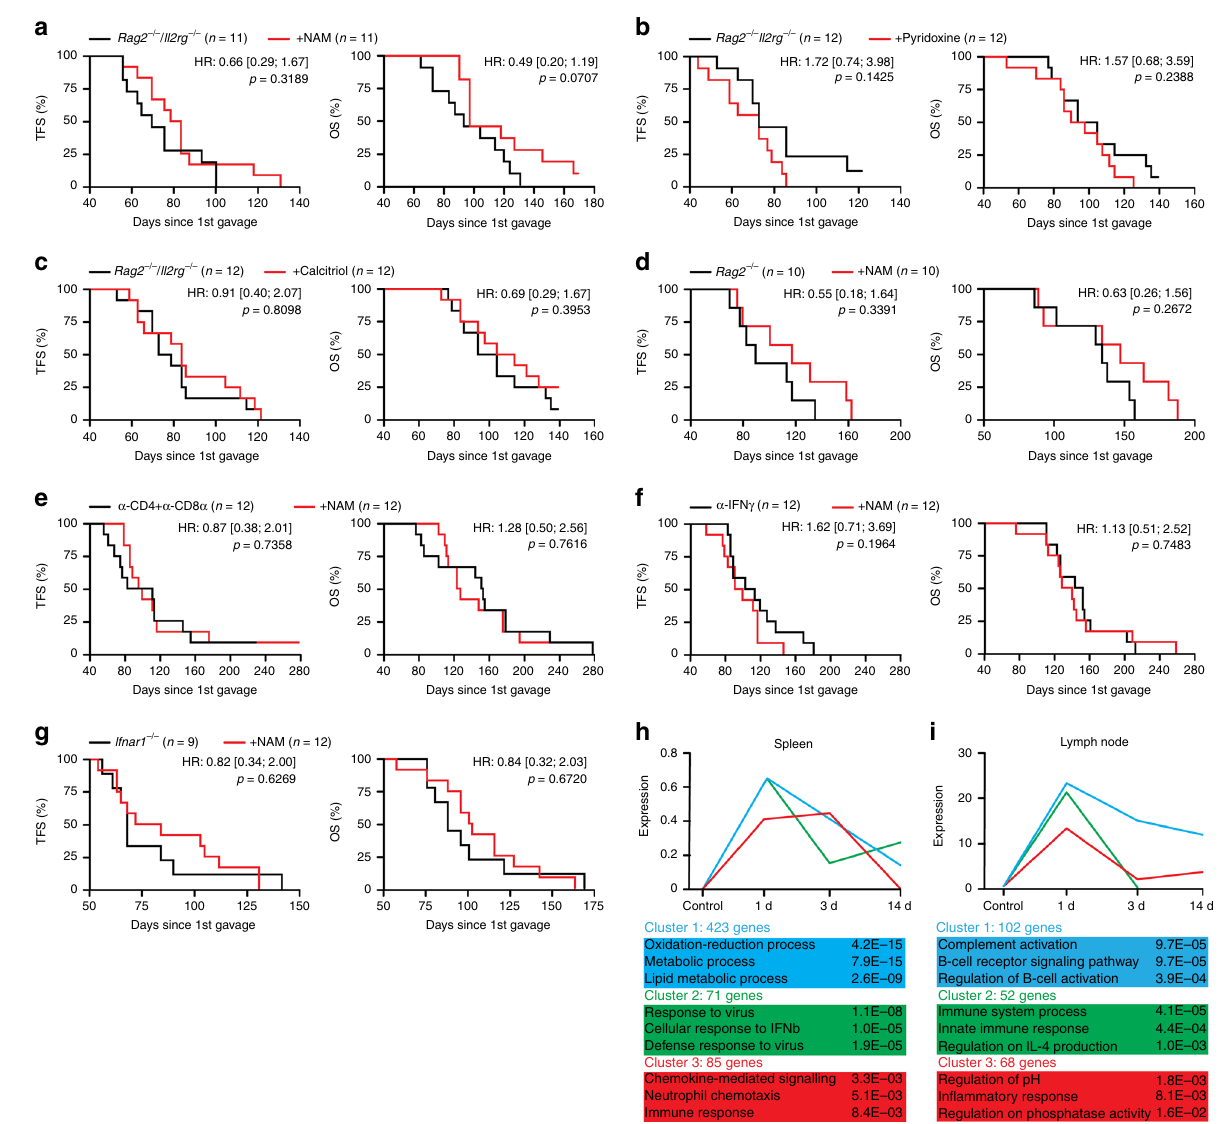
Fig. 5 NAM mediates chemopreventive effects by boosting immunosurveillance. a – c Tumor-free survival (TFS) and overall survival (OS) of Rag2 − / − Il2rg − / − mice subjected to M/D-driven oncogenesis in control conditions ( a – c ) or along with NAM ( a ), pyridoxine ( b ) or calcitriol ( c ) supplementation. Number of mice, hazard ratio (HR) and p values (two-sided log-rank) are reported. d – g TFS and OS of Rag2 − / − mice ( d ), C57BL/6 mice receiving CD4- and CD8 α -depleting antibodies ( e ), C57BL/6 mice receiving an IFNG-neutralizing antibody ( f ), and Ifnar1 − / − mice ( g ) subjected to M/D-driven oncogenesis in control conditions or along with NAM supplementation with the drinking water. Number of mice, HR and p values (two-sided log-rank) are reported. h , i Gene sets enriched in the spleen ( h ) and lymph nodes ( i ) of tumor-naive C57BL/6 mice receiving NAM supplementation with the drinking water for 1, 3 or 14 days. Adjusted, two-sided p values for enrichment are